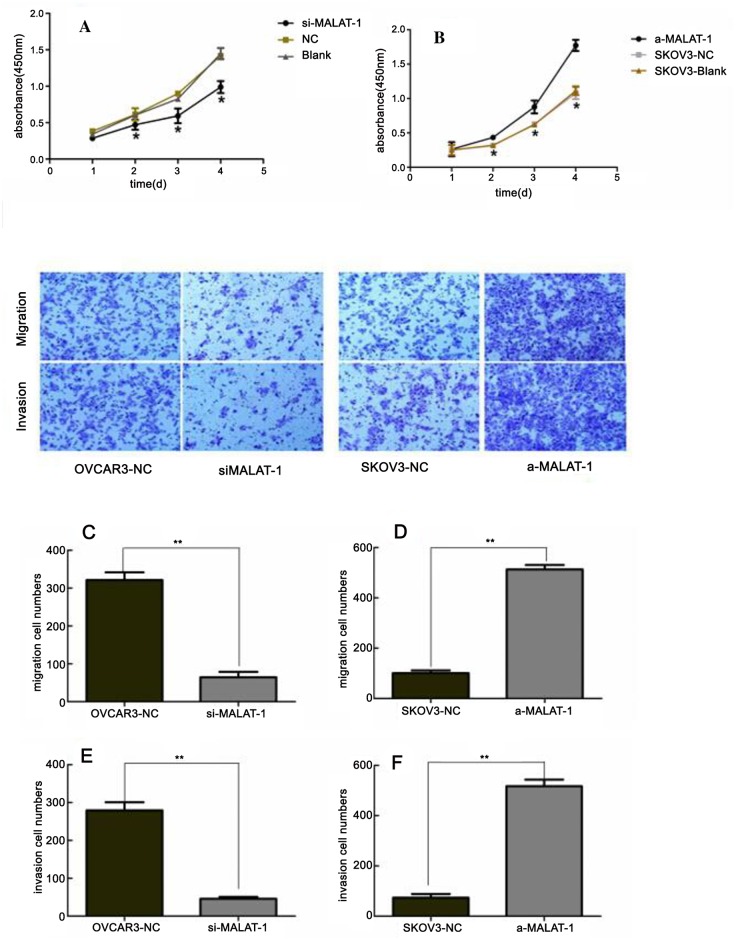
Suppression of MALAT-1 expression inhibits OVCAR3 cell growth, migration, and invasion, overexpression of MALAT-1 expression promotes SKOV3 cell growth, migration and invasion.(A) and (B) Cell proliferation CCK-8 assay. Ovarian cancer cells were grown and transfected and then subjected to CCK-8 assay. *p < 0.05 versus control groups. (C) and (D) Transwell tumor cell migration assay. Ovarian cancer cells were grown and transfected and then subjected to Transwell tumor cell migration assay.(E) and (F) Transwell tumor cell invasion assay. Ovarian cancer cells were grown and transfected and then subjected to Transwell tumor cell invasion assay **p < 0.0001 versus control groups.